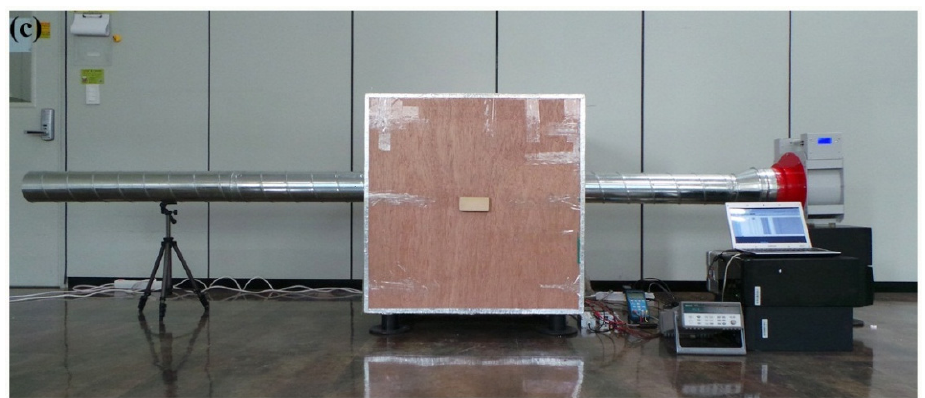
Figure 4. The equipment and temperature sensors for ( a ) the baseline test; ( b ) the LHEM test; and ( c ) the overall view of the test chamber with the LHEM